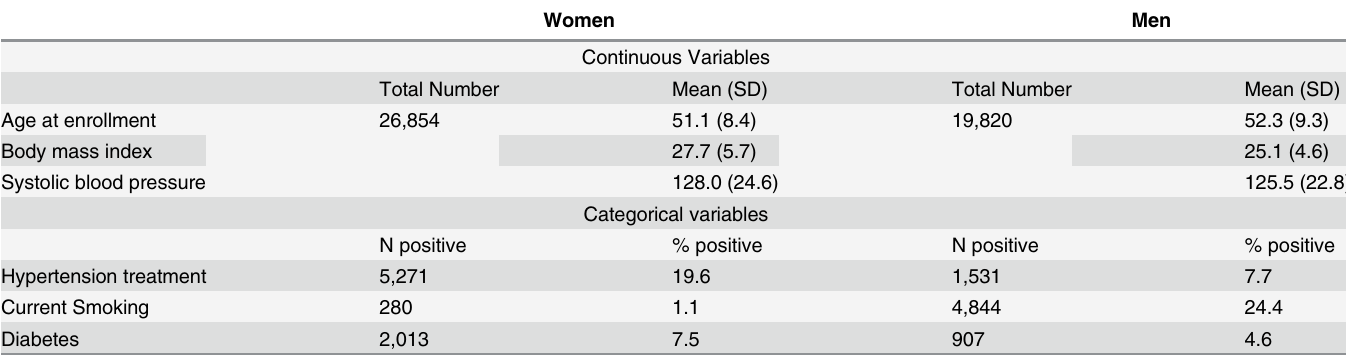
Table 1. Summary statistics of CVD risk factors in the Golestan Cohort.